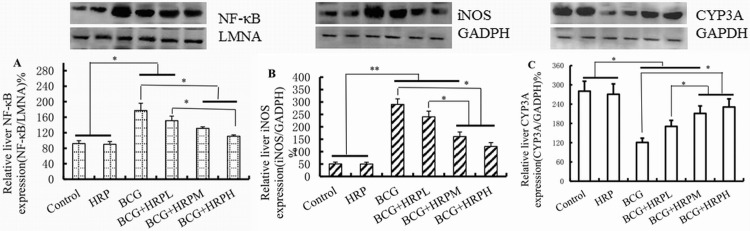
Effects of HRP on NF-κB, iNOS, and CYP3A expression in rat livers following immune-mediated injury.Rats were treated with BCG (125 mg kg-1, intravenously, once for 2 wks) or BCG + HRP (50, 100, or 200 mg kg-1 d-1, oral administration for 13d). Liver proteins were extracted to determine NF-κB, iNOS, and CYP3A expression. Equal amounts (30 μg) of protein were subjected to SDS-PAGE followed by western blot analysis using anti-NF-κB, anti-iNOS, and anti-CYP3A antibodies. Results were normalized to LMNA or GAPDH. NF-κB (A), iNOS (B), and CYP3A (C) protein expression levels in rat liver were measured by western blot. NF-κB, iNOS, and CYP3A expression levels were quantified by ImageQuant software (GE Healthcare Life Science, Little Chalfont, UK). Data represent means ± SD of three independent experiments. Asterisks stars above bars indicate differences between groups.